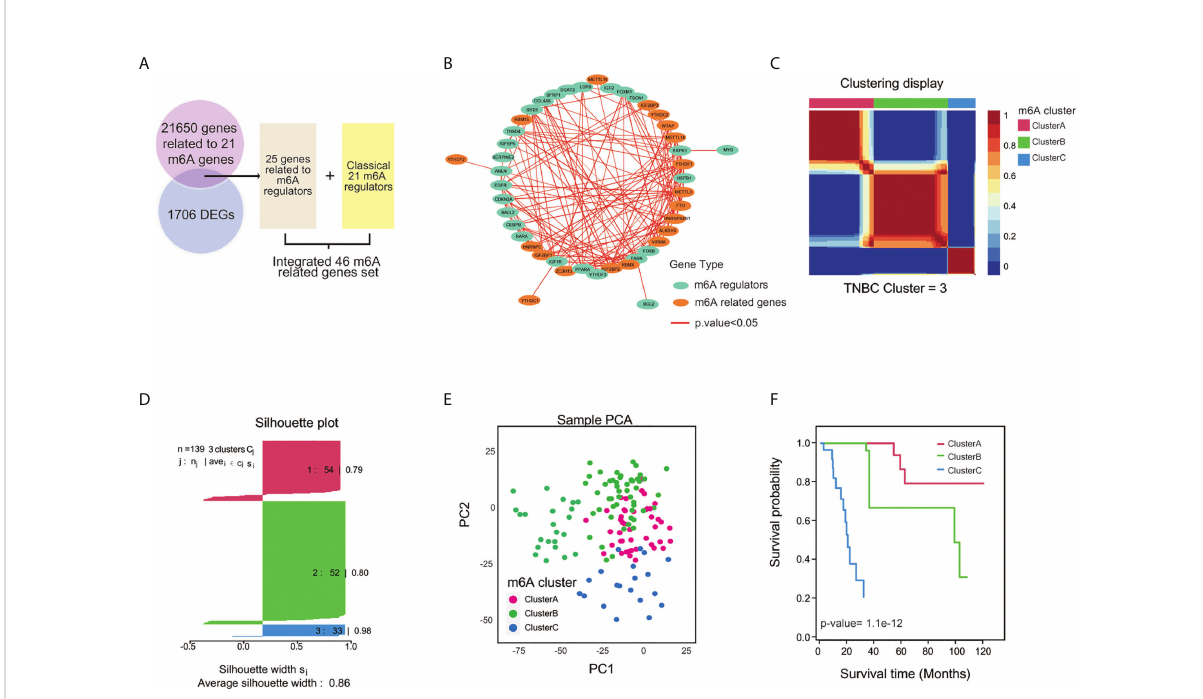
FIGURE 3 Clustering TNBC based on m6A-related genes by NMF analysis. (A) The fl ow diagram illustrated the process of selecting 46 m6A-related genes. (B) The correlation network of 46 m6A-related genes among 139 TNBC cases with p.value<0.05. (C) Three m6A clusters by Principal Component Analysis (PCA). (D) TNBC samples were clustered by the Nonnegative Matrix Factorization (NMF) method. (E) Silhouette width plots of NMF analysis. (F) K-M curve for comparing the overall survival among three clusters by the “ CancerSubtypes ”